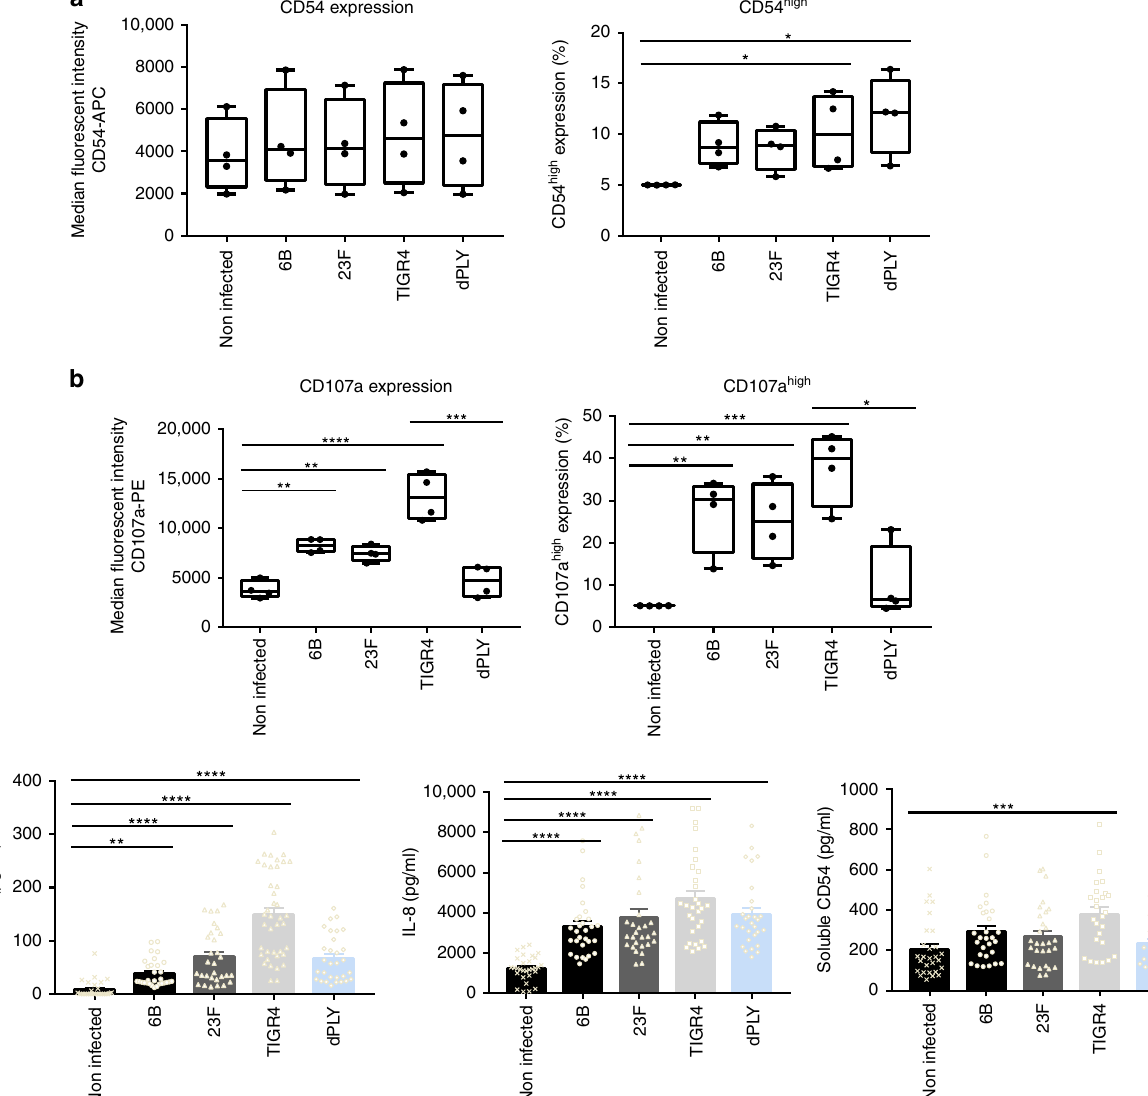
Fig. 5 Epithelial innate activation following pneumococcal infection in vitro. a , b Detroit 562 cells were stimulated with S. pneumoniae for 6 h and the median fl uorescence intensity and high-expressing cells for ( a ) CD54 and ( b ) CD107a were analysed by fl ow cytometry. n = 3 independent experiments (**** P < 0.0001 CD107a MFI, compared with non-infected cells, ANOVA. *** P = 0.0009 for MFI CD107a, TIGR4 vs dPly, unpaired T-test. *** P < 0.001 CD107a high expression, compared with non-infected cells, ANOVA. * P = 0.028 for high expression CD107a, TIGR4 vs dPly, Mann – Whitney). (* P = 0.048 NI vs TIGR4; * P = 0.0367 NI vs dPly for CD54, ANOVA). Boxplots represent the median (centre line) and interquartile range (box), minima and maxima (whiskers). c IL-6, IL-8 and CD54 in the supernatants from Detroit 562 cells stimulated with S. pneumoniae for 6 h, were measured by ELISA. N = 6 independent experiments with replicates (**** P < 0.0001 IL-6; *** P = 0.0013 CD54; **** P < 0.0001 IL-8 (Kruskall – Wallis test)). Error bars represent